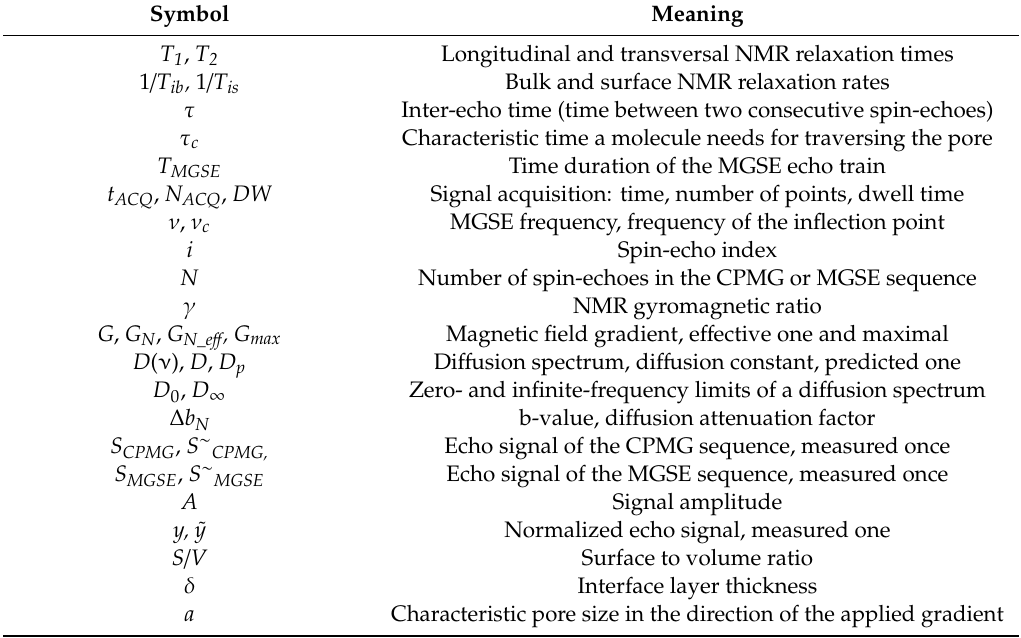
Table 1. List of mathematical symbols used in the equations and